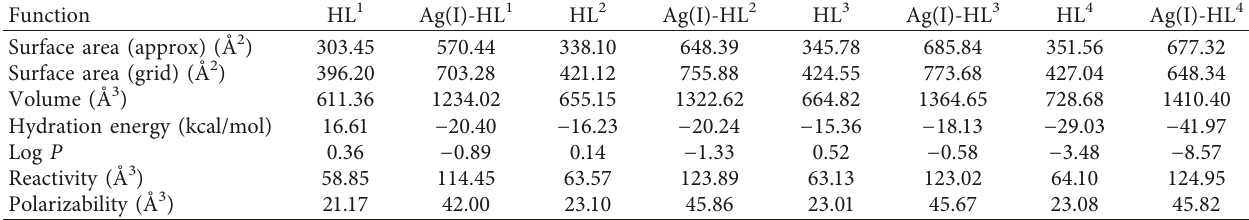
Table 6: QSAR computation for pyrazolone ligands and their Ag(I) complexes.